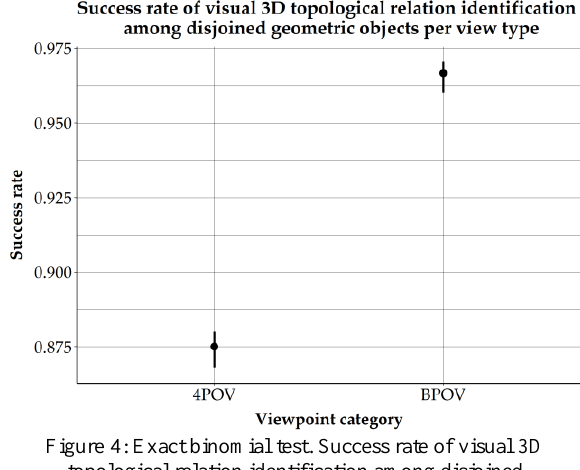
Figure 4: Exact binomial test. Success rate of visual 3D topological relation identification among